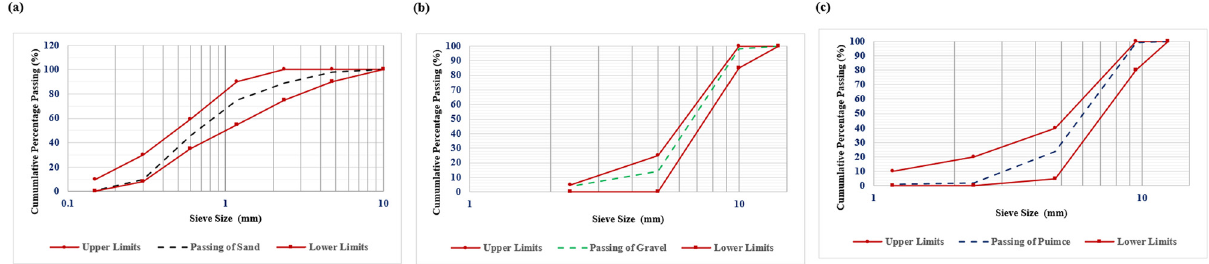
Figure 1: Grading curves of fi ne and coarse aggregate: ( a ) sand, ( b ) gravel, and ( c ) pumice